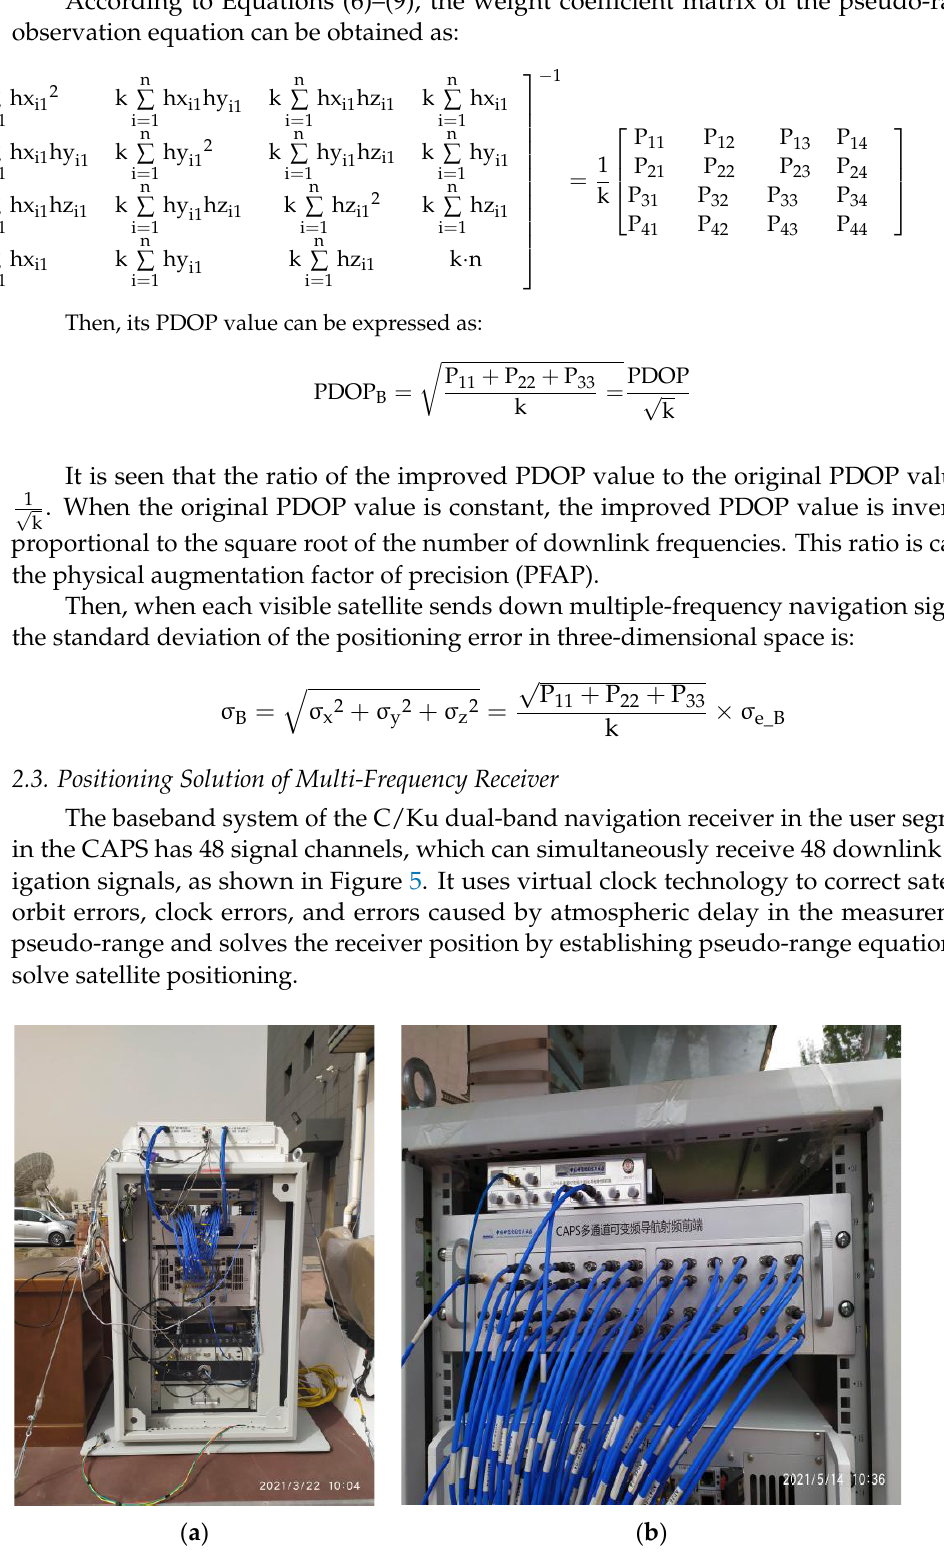
Figure 5. CAPS navigation receiver: ( a ) is the physical diagram of the CAPS receiver, including multi-beam antenna, frequency converter, radio frequency device, signal channel, intelligent control terminal (including memory, CPU, display), power supply, etc.; ( b ) is a variable frequency navigation radio frequency device with 48 channels.